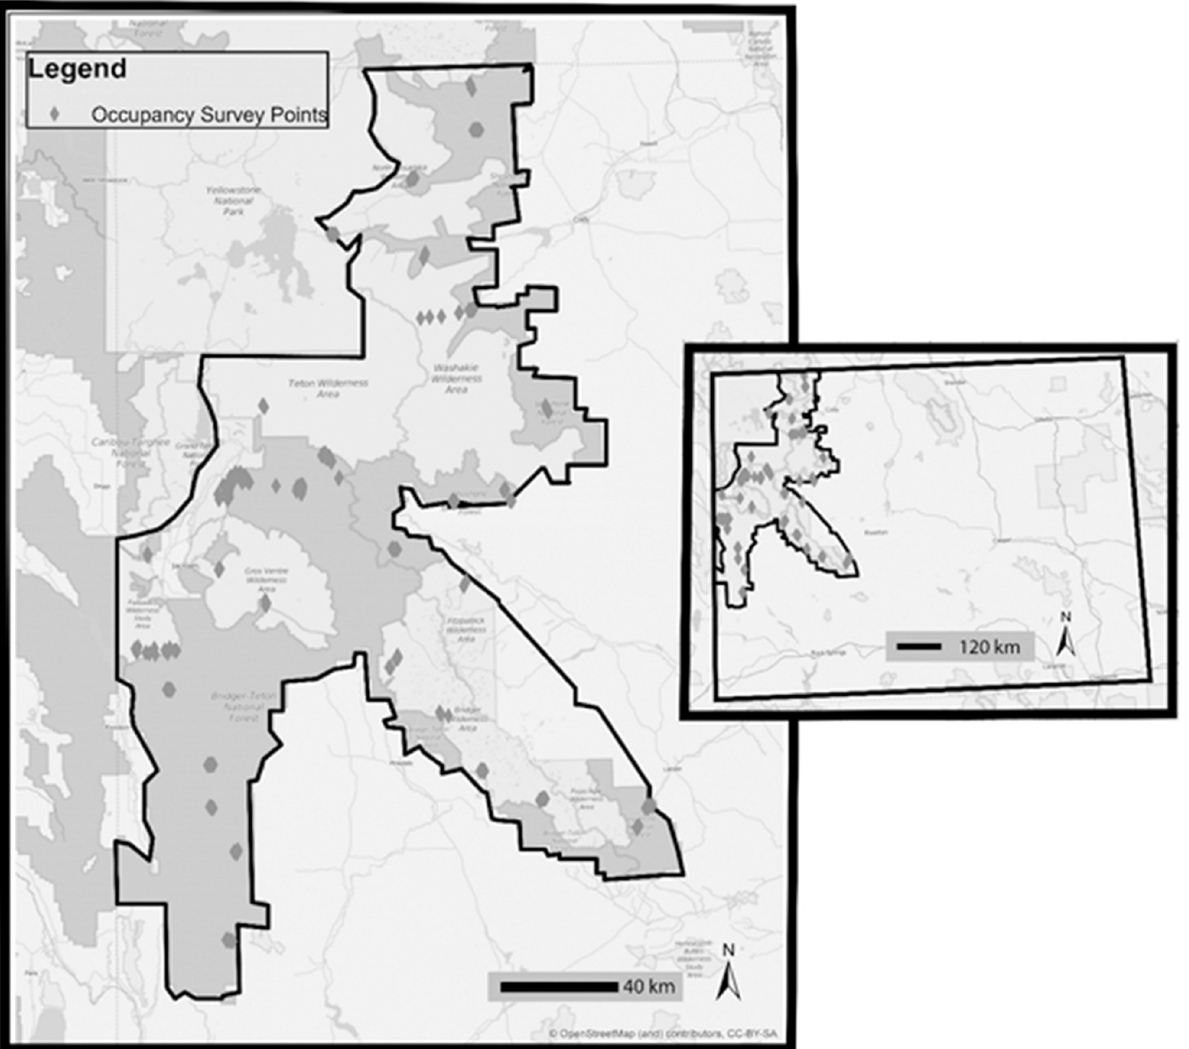
Fig 1. Study area in the Greater Yellowstone Ecosystem. The inset map depicts the study area within the state of Wyoming. (Reprinted from map data © OpenStreetMap contributors, map layer by Esri, under a CC BY-SA 4.0